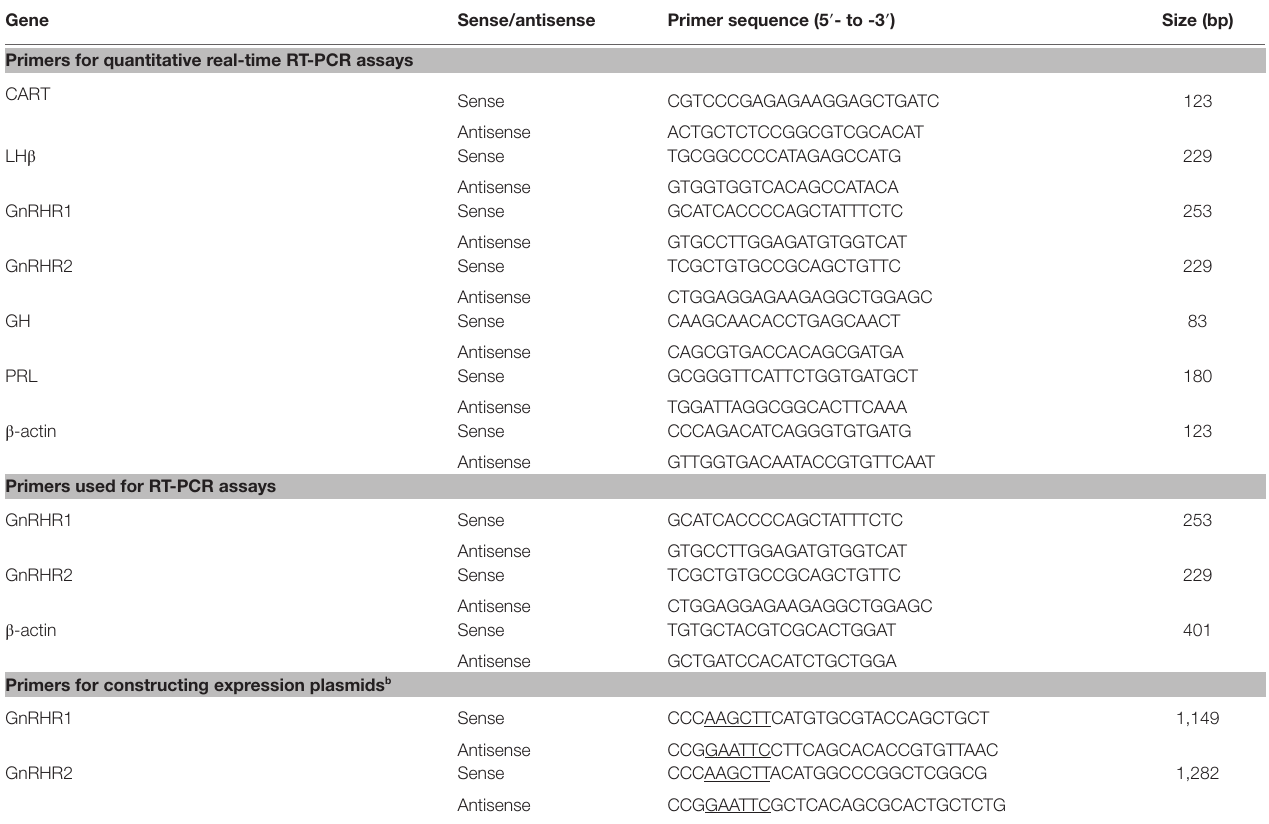
TABLE 1 | Primers used in this study. a